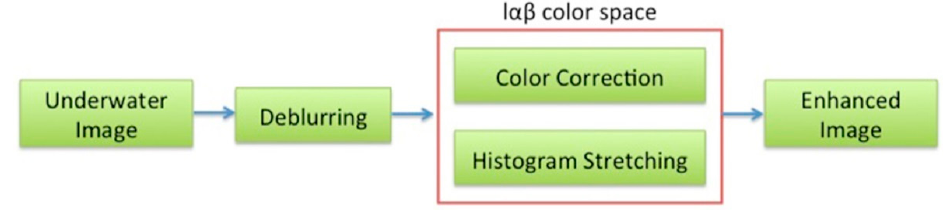
Figure 12. Flow-chart of the image enhancement steps.